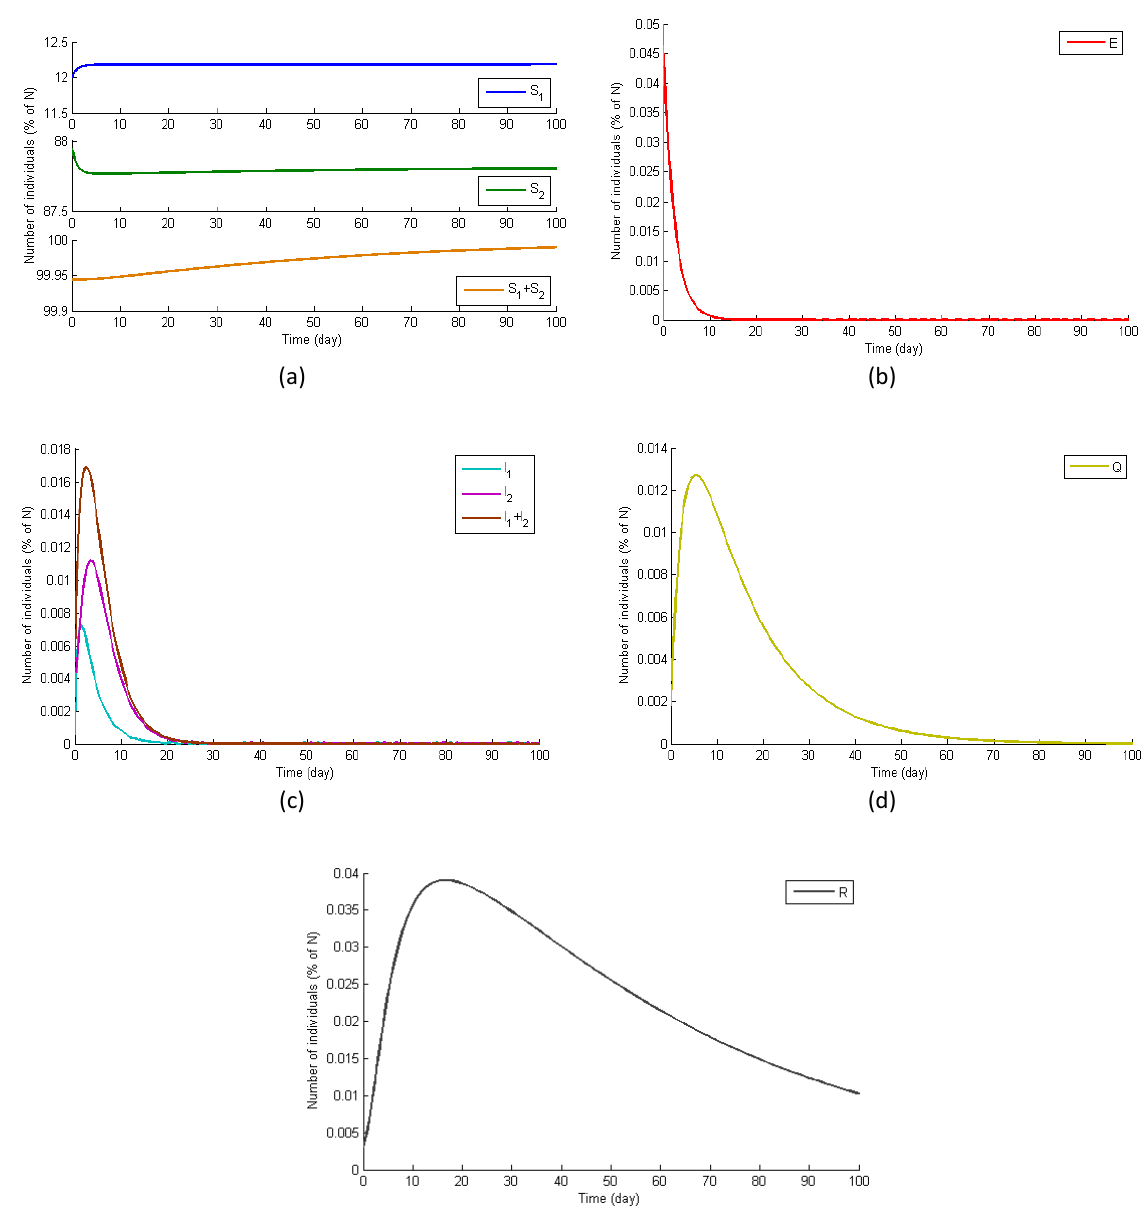
Fig. 4 : The subpopulation spread of COVID-19 with